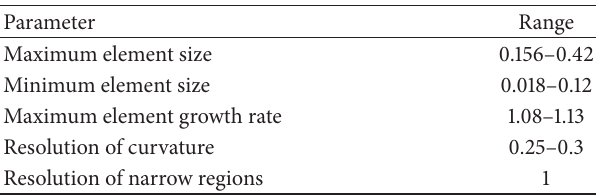
Table 2: Computational grid meshing layer